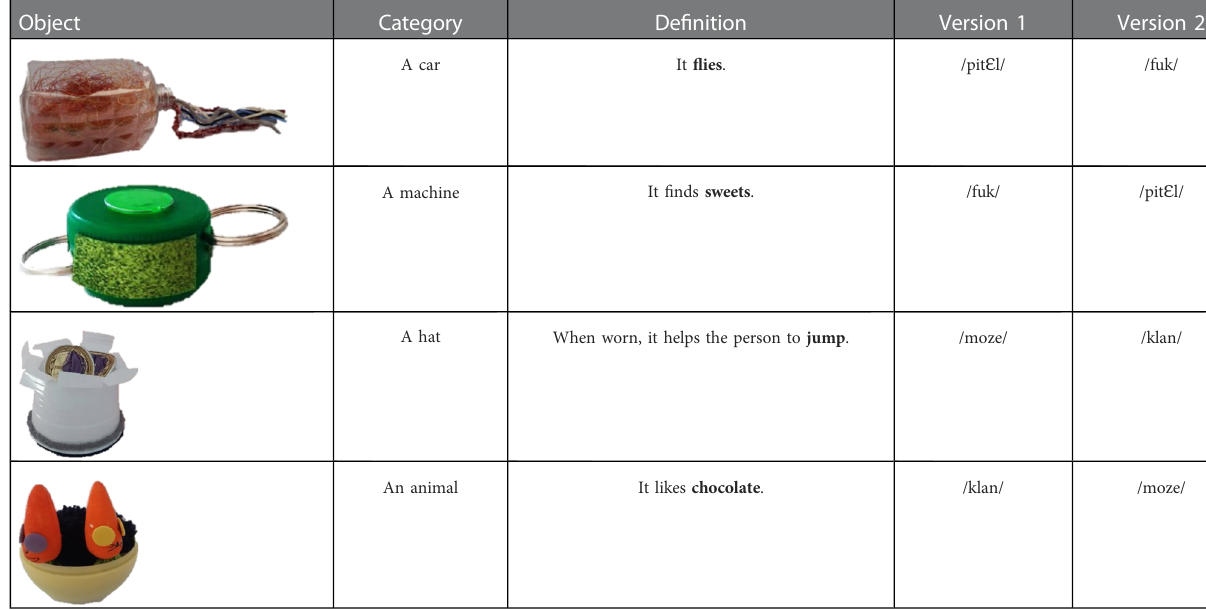
TABLE 2 Objects,semantic features and non-words associated.